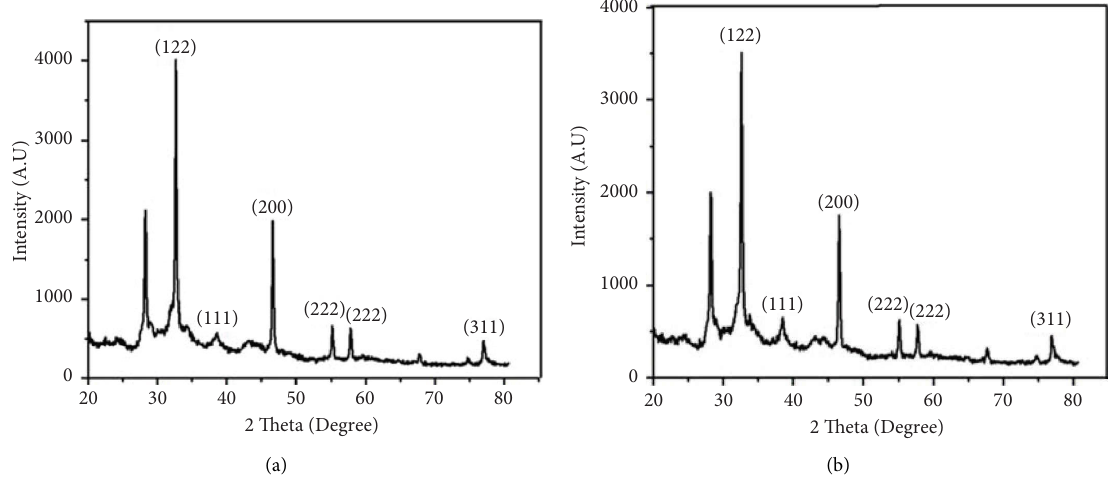
Figure 2: XRD patterns on AgNPs synthesized using Aloe vera leaf extract solution. (a) 6hours hydrothermal at 100 ° C; (b) 12 hours hydrothermal at 100 ° C.